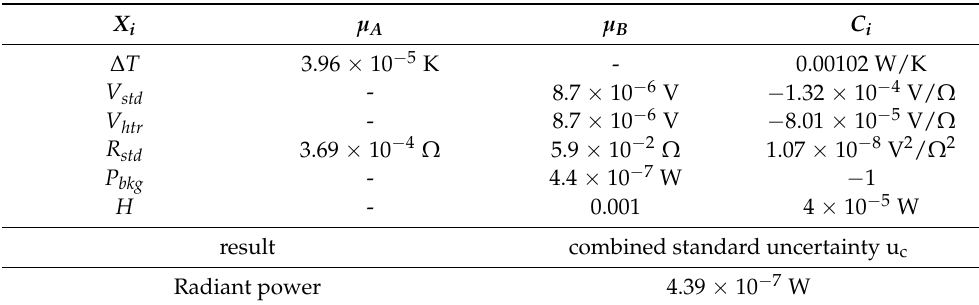
Table 2. Contributions to the standard uncertainty of radiant power P ( k = 1) for measurement with the CESR at photon energy of 10 keV.